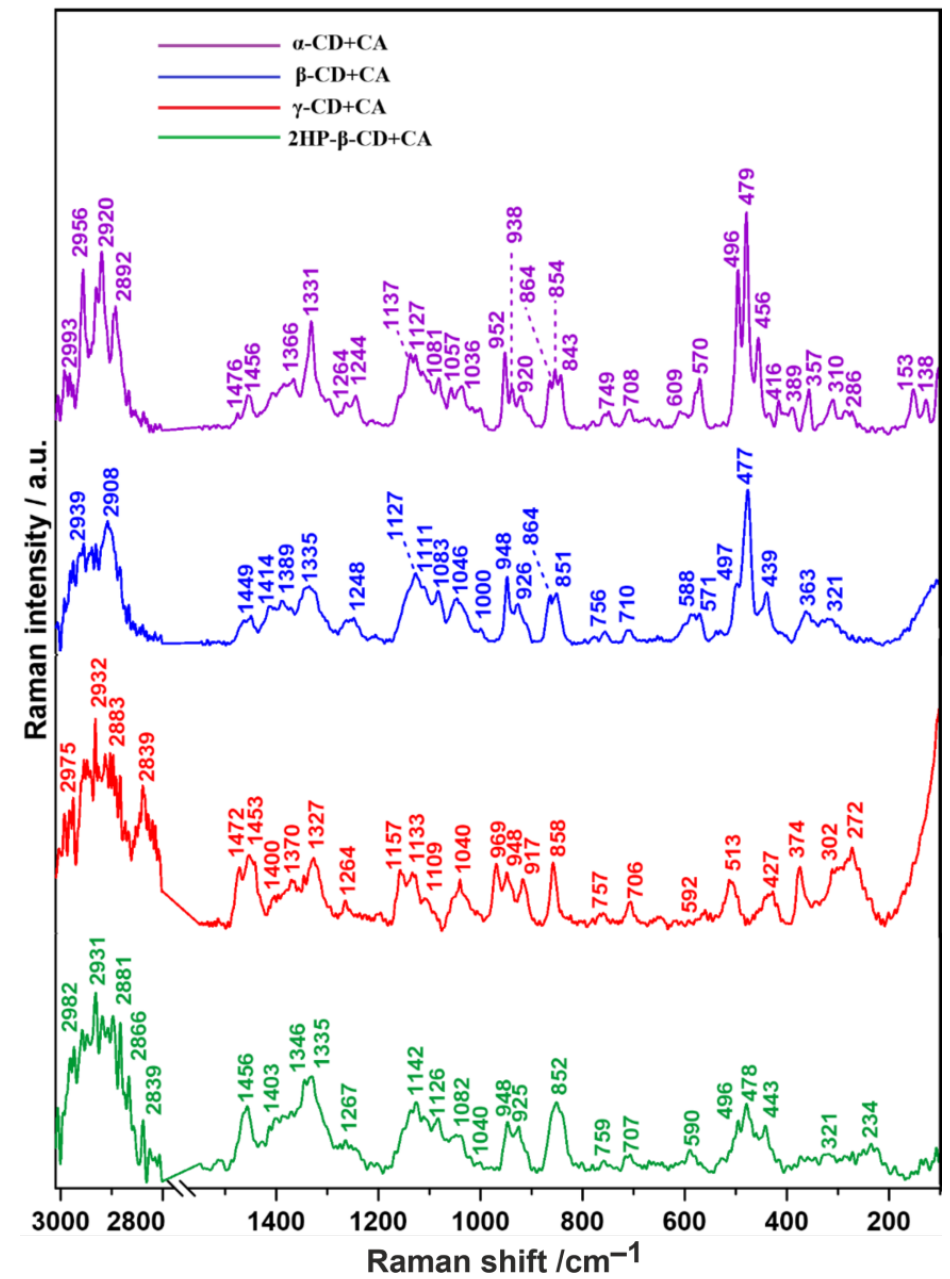
Figure 4. Raman spectra of inclusion complexes of cefuroxime axetil with α-, β-, γ-CDs and 2HP-β-CD along with band assignments. Table 2. The most significant bands recorded in the Raman spectra of studied CA–CD complexes (assignments were made in accordance with refs. [44–47]).